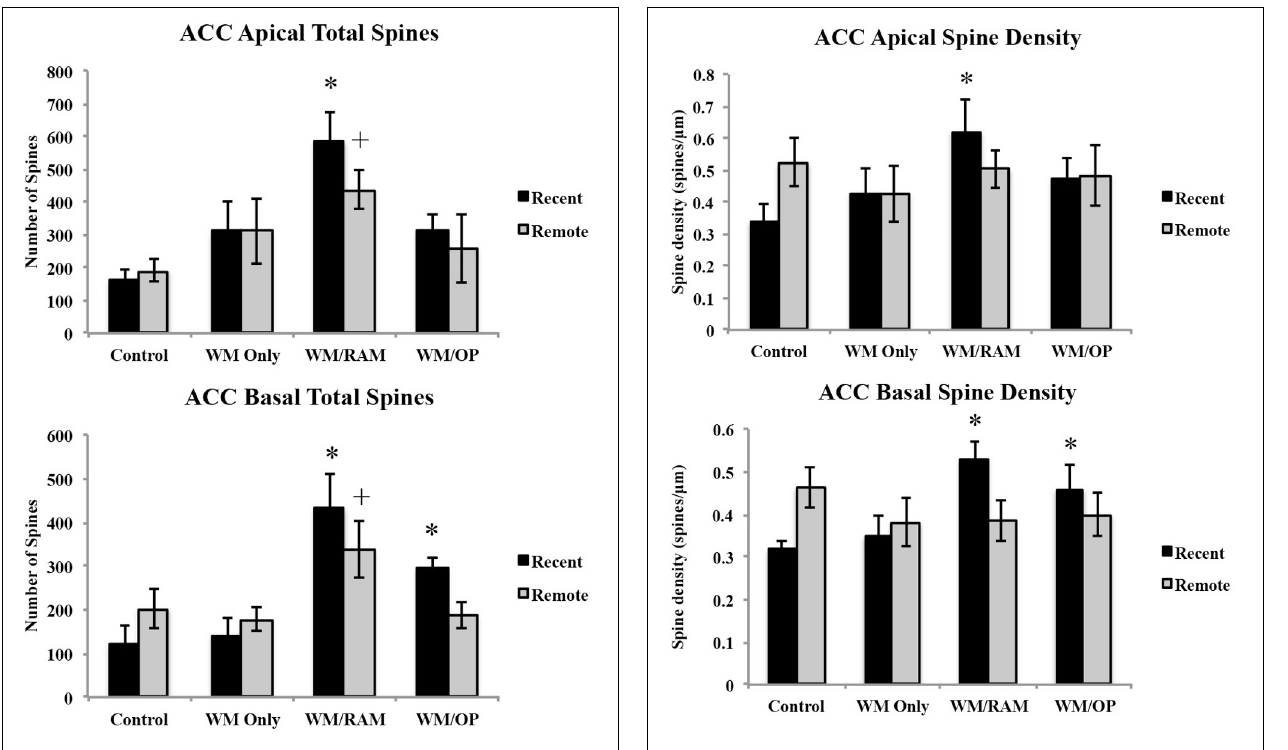
FIGURE 6 | Total number of spines in the ACC in apical and basal dendrites. Only significant differences between behavioral groups and their respective control group are displayed. Refer to Results section for all comparison results. ∗ Significantly different from Control:recent group ( p < 0 . 05); + Significantly different from Control:Remote ( p < 0 . 05).